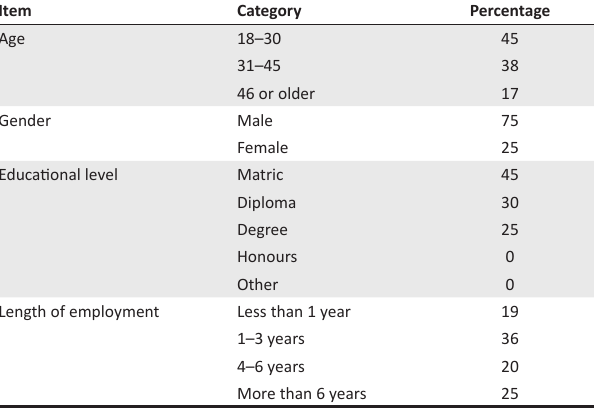
TABLE 2: Demographic characteristics of respondents.